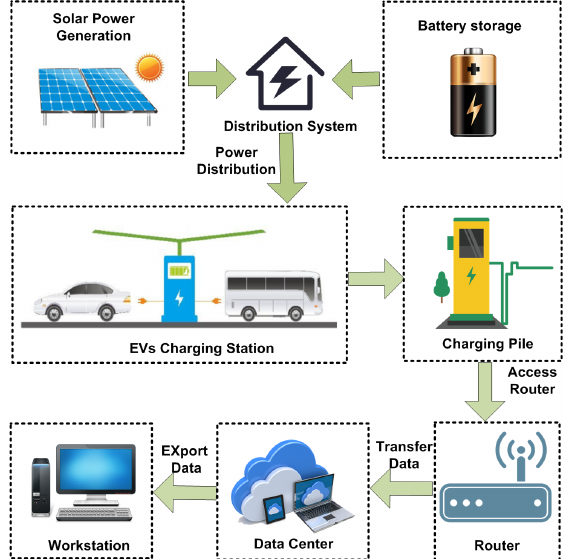
Figure 5. Power distribution mode and data statistics